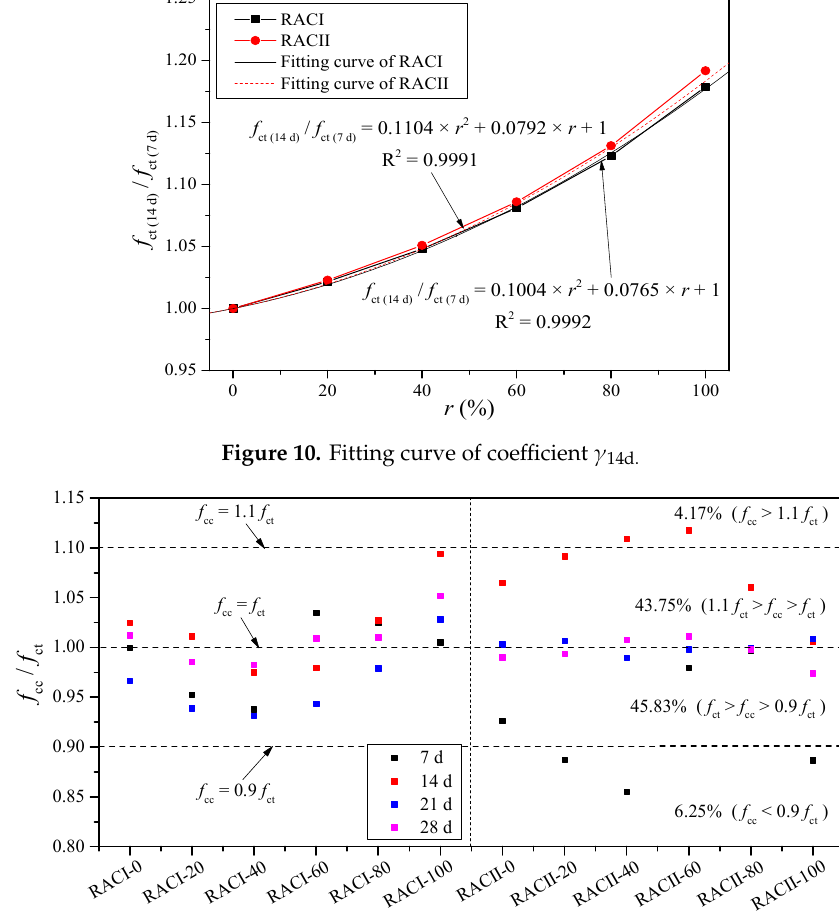
Figure 10. Fitting curve of coefficient γ 14d.